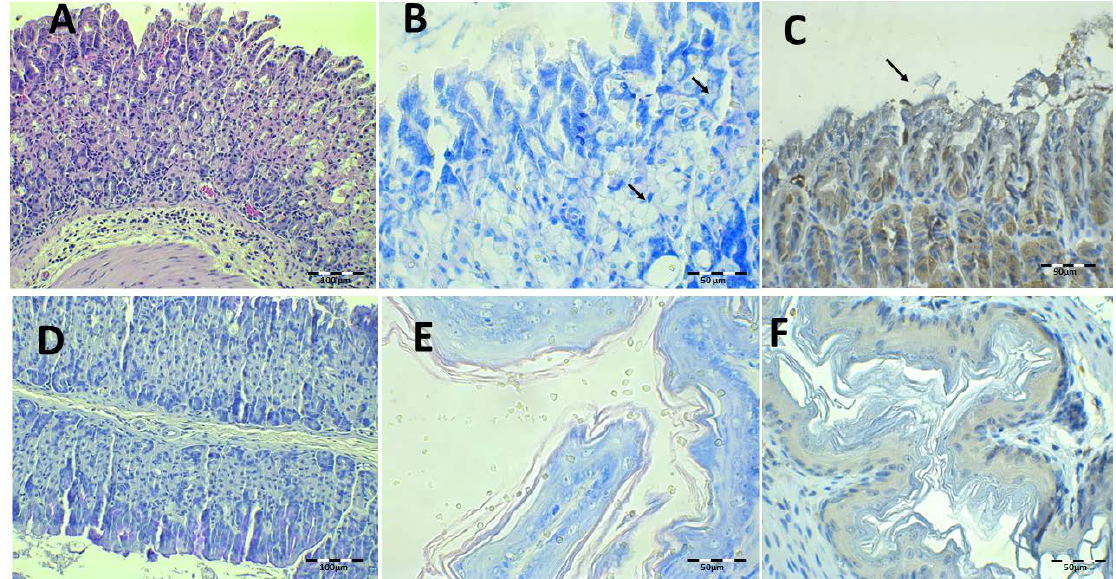
Figure 13. Infected animals treated with 44.7 mg/kg/day of Amox and 22.35 mg/kg/day of Clar in PBS microphotographs of the stomach ( A – D ) and esophagus ( E , F ), stained with H-E ( A ), Giemsa ( B , E , arrows indicate H. pylori bacteria), IHC ( C , F , arrows indicate H. pylori bacteria), and PAS ( D